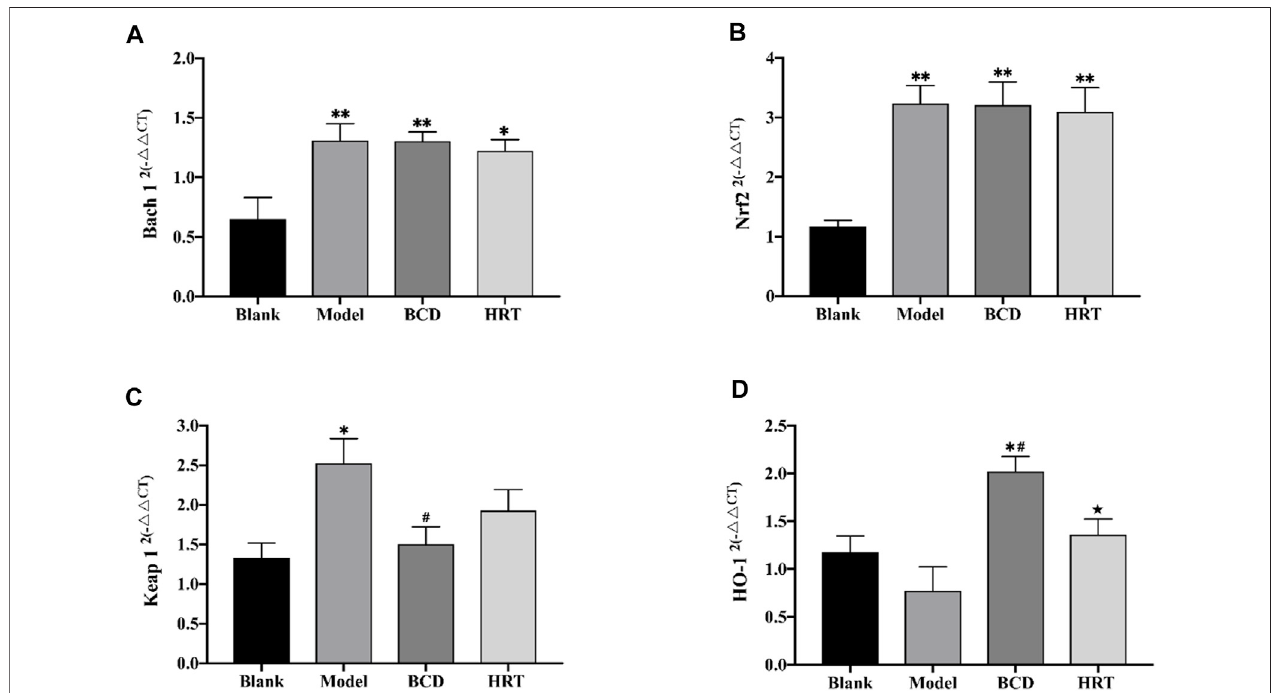
FIGURE 6 | TWP activates transcription of Nrf2/Keap 1 pathway in ovaries of POI mice. The mRNA levels of Bach 1 (A) , Nrf2 (B) , Keap 1 (C) , and HO-1 (D) as assessedusingbyRT-PCR.Thedataisvisualizedintermsofmeans±SEM.(* p < 0.05,** p < 0.01,comparedwiththeBlankgroup; # p < 0.05, ## p < 0.01,comparedwith the Model group; + p < 0.05, ++ p < 0.01, compared with the BCD